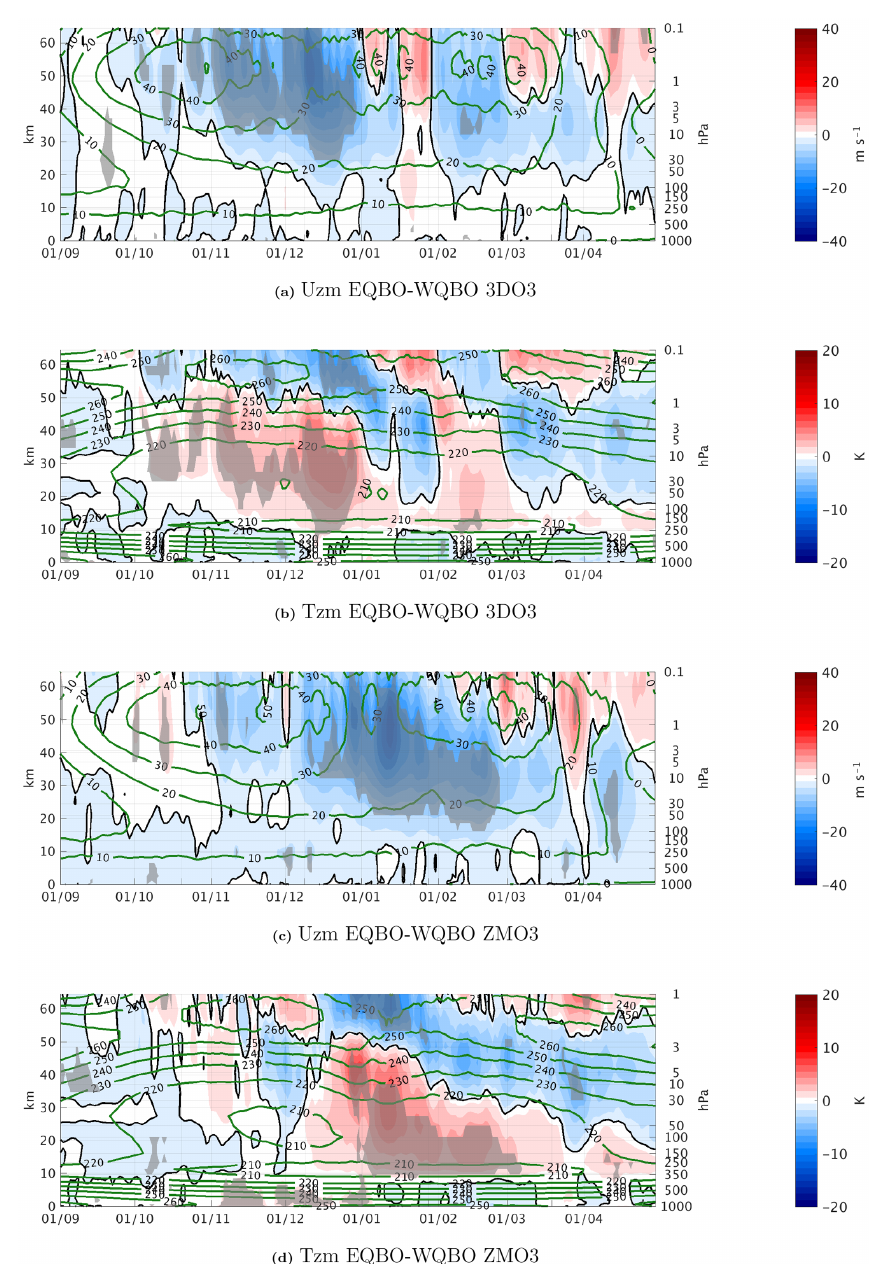
Figure 4. Daily climatology differences between east and west QBO phases of the zonal mean zonal wind averaged over 75–55 ◦ N for the 3DO 3 (a) and ZMO 3 (c) runs, and the zonal mean temperature, averaged over 90–66 ◦ N for the 3DO 3 (b) and ZMO 3 (d) runs, for September–March. Statistically significant areas are shown by gray